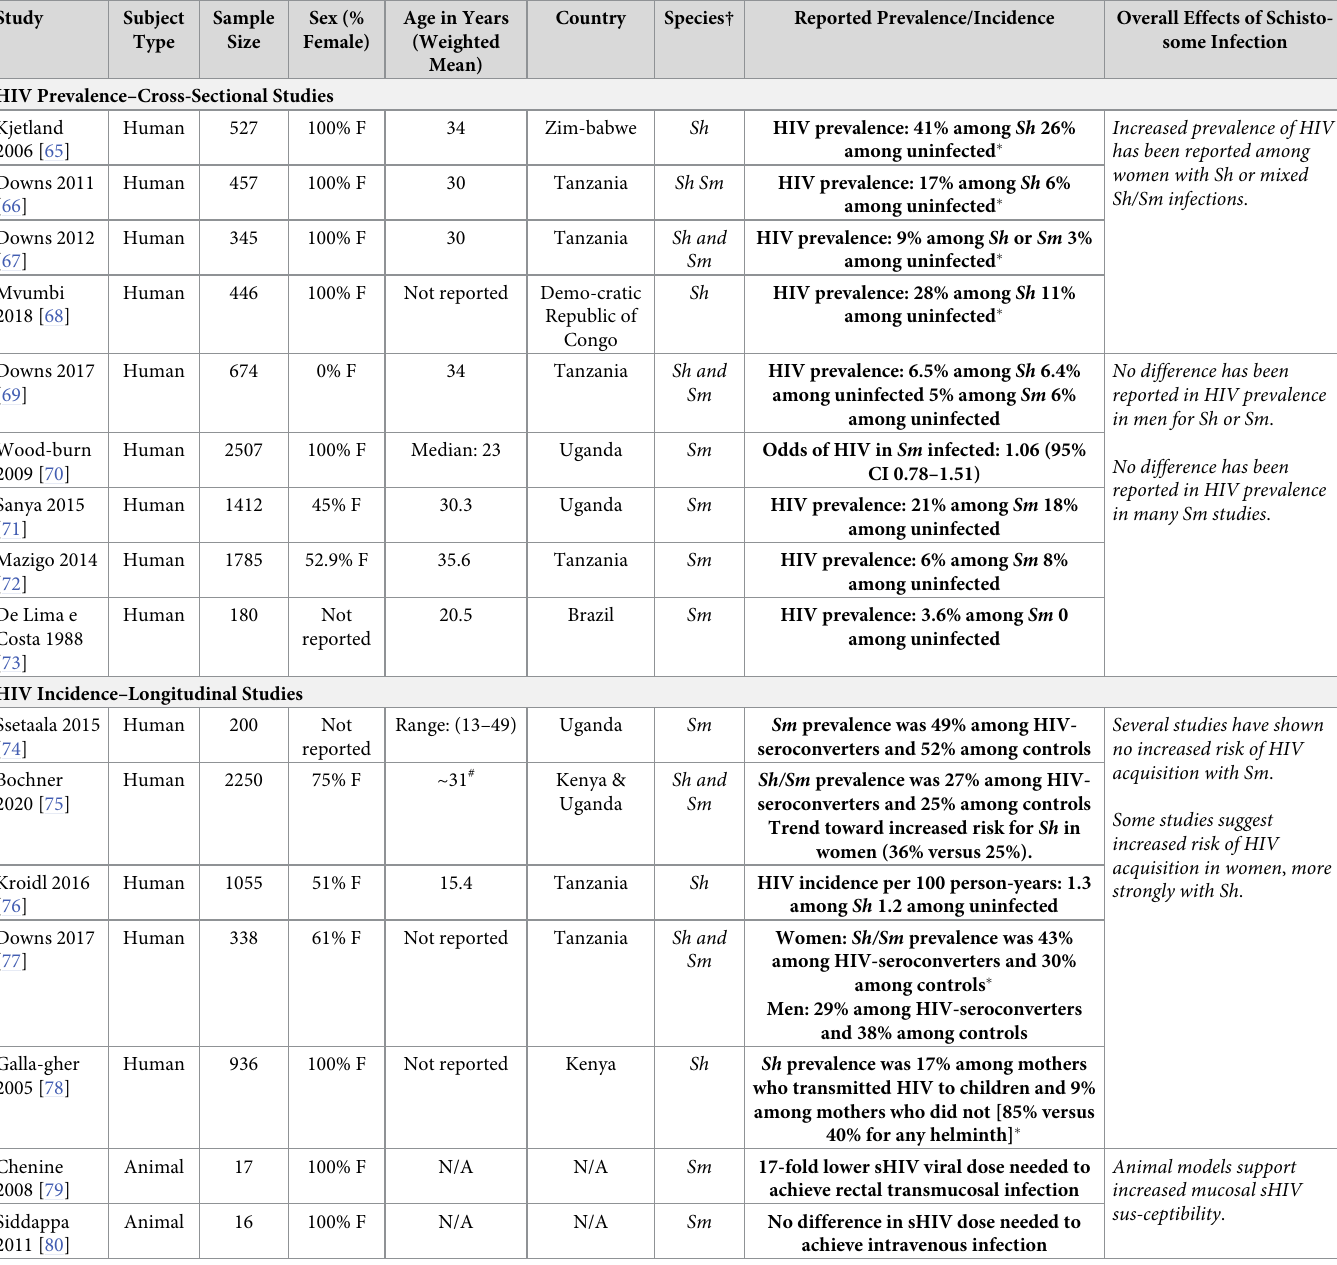
Table 4. Prevalence and Incidence of HIV Among Schistosome-Infected and Uninfected Individuals.